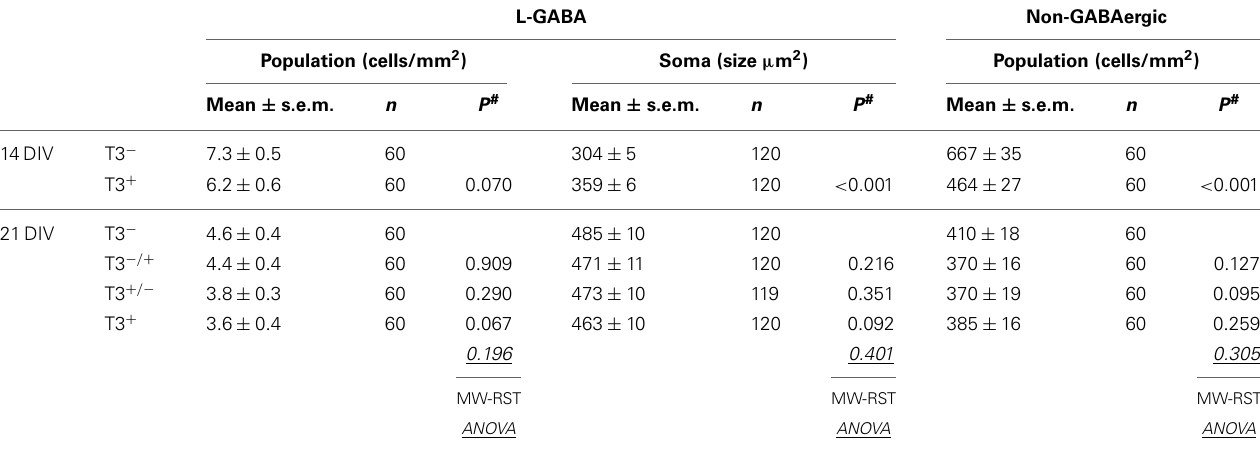
Population statistics of non-GABA is also shown. Treatment groups and statistics as in Table 1 . n, number of fields (L-GABA and non-GABA populations) or number of L-GABA (soma size).